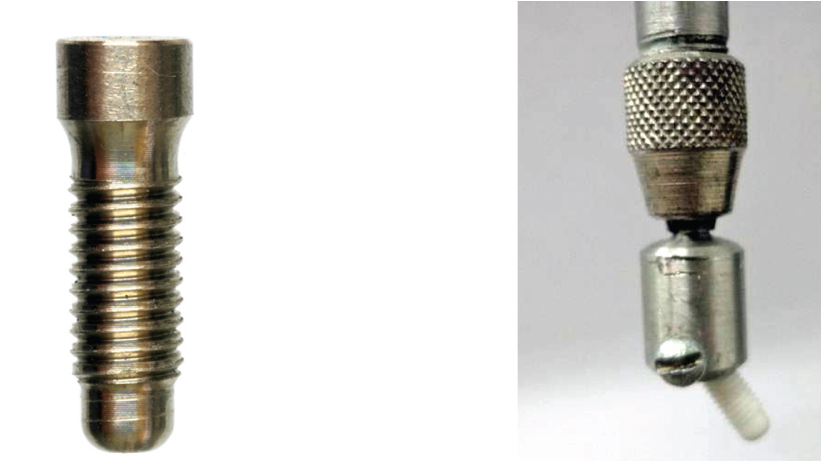
Figure 3. Device to insert implants coupled to the parallelometer used to insert implants in polyurethane resin at an angle of